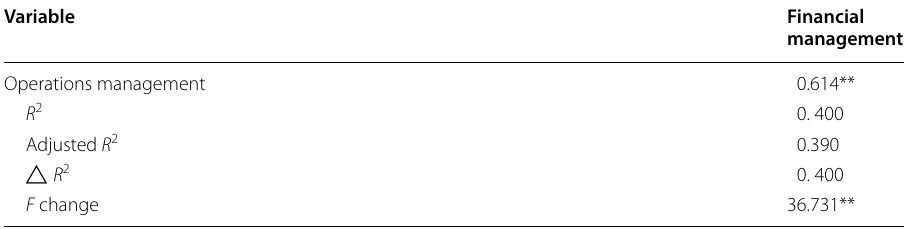
Level of significant: * p < 0.10, ** p <